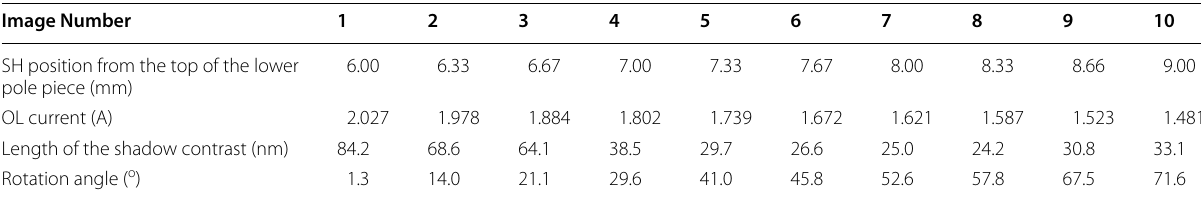
Table 1 SH setting conditions and their corresponding OL current values, magnitude of length, and rotation angle of the shadow contrast